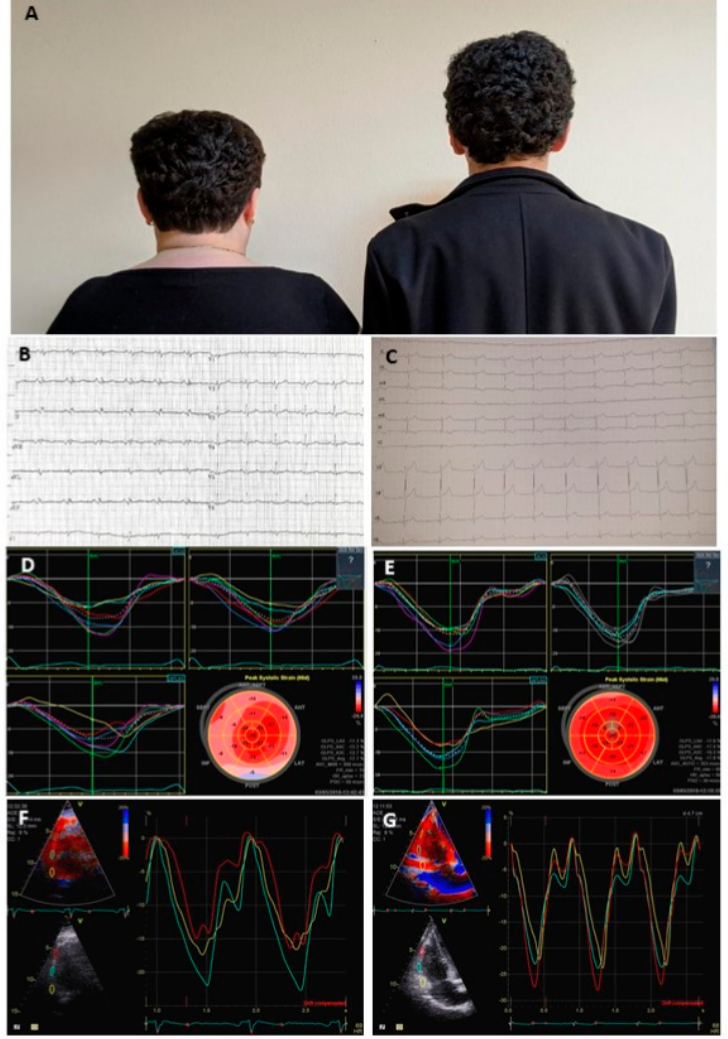
Figure 1. ( A ) Phenotypic findings in the mother and son: curly hair is noted; ( B ) electrocardiographic tracing of the mother: low voltage fragmented QRS complexes without ST-T changes. ( C ) Electrocardiographic tracing of the son: respiratory arrhythmia. ( D ) Speckle tracking echocardiography-derived left ventricle (LV) longitudinal strain segmental tracings and bull’s eye in the mother—showing abnormal myocardial amplitude in the basal and mid septal and lateral segments. ( E ) Speckle tracking echocardiography-derived LV longitudinal strain segmental tracings and bull’s eye with normal myocardial deformation in the son. ( F ) Free right ventricular (RV) wall tissue Doppler segmental strain tracings of the mother with abnormal amplitude of the deformation curves in the basal and apical segments. ( G ) Free RV wall tissue Doppler segmental strain tracings of the son with normal amplitude and shape of the curves. See text for further details.